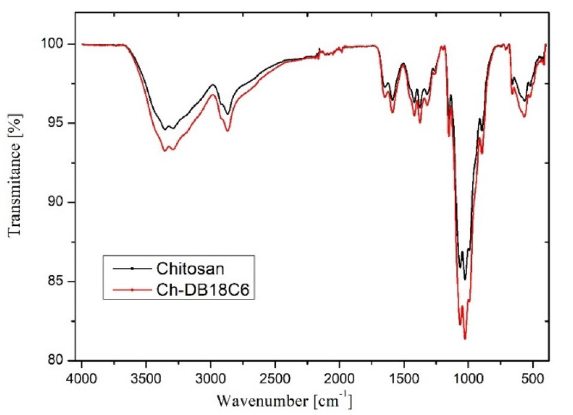
Figure 3. FT-IR spectra for Ch and Ch-DB18C6.